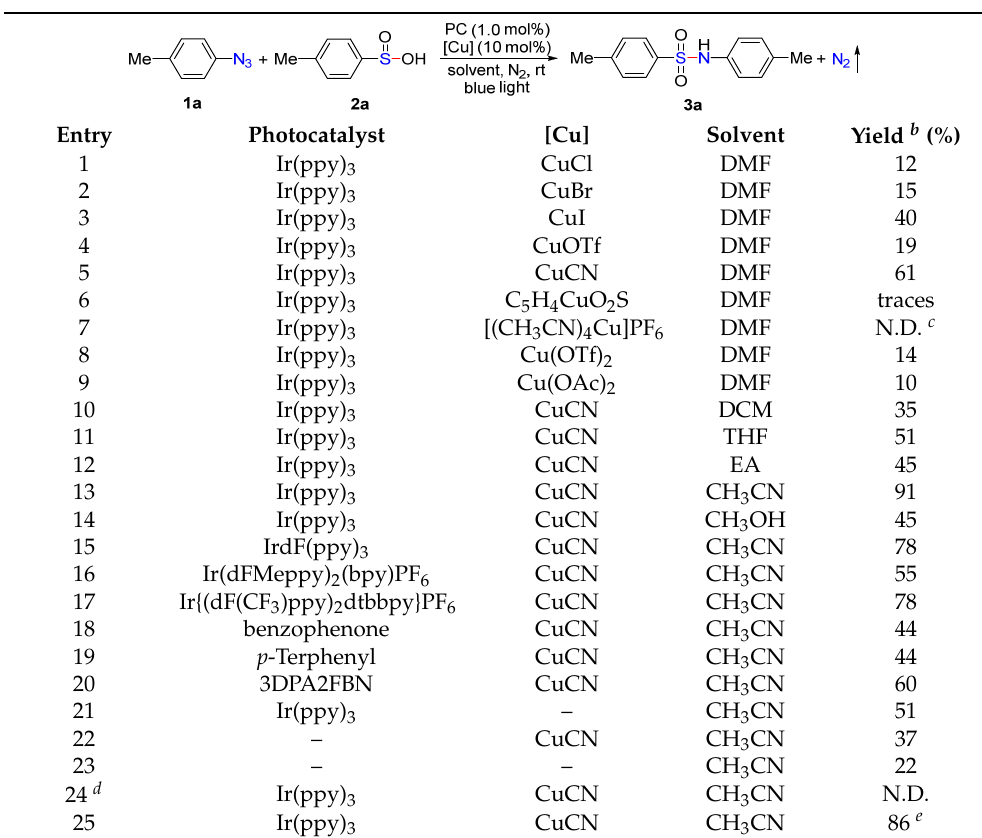
Table 1. Optimization of reaction conditions a .